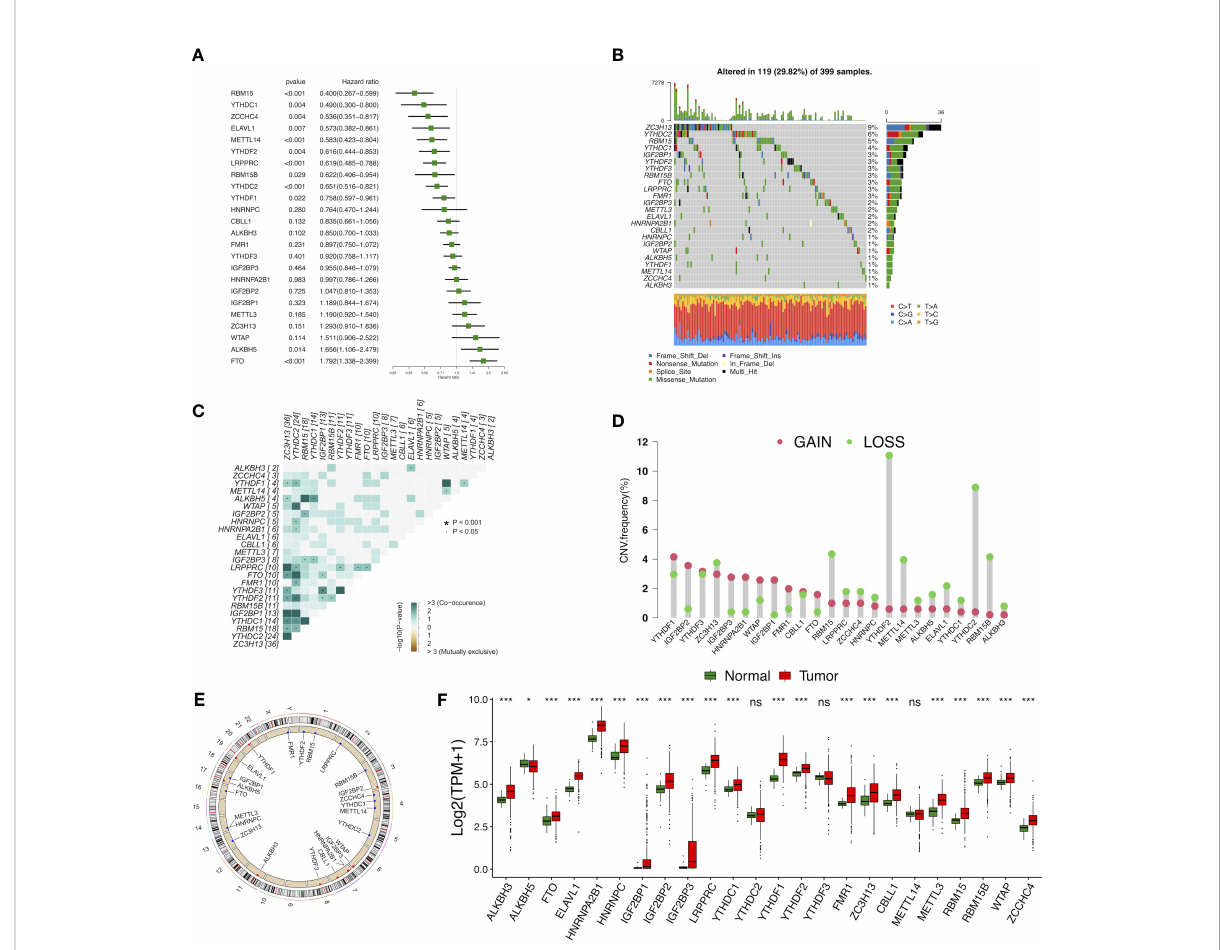
FIGURE 2 Landscape of genetic and expression variation of m6A modulators in colon cancer. (A) The prognostic analyses for 24 m6A modulators in the fi ve colon cancer cohorts with univariate Cox regression. (B) The mutation frequency of 24 m6A modulators. (C) The mutation co-occurrence along with exclusion analyses for 24 m6A modulators. (D) The CNV variation frequency of 24 m6A modulators. (E) The location of CNV alteration of m6A modulators on 23 chromosomes. (F) The expression of 24 m6A modulators between normal tissues and tumor tissues. ns, Not signi fi cant; *p < 0.05, **p < 0.01, ***p <